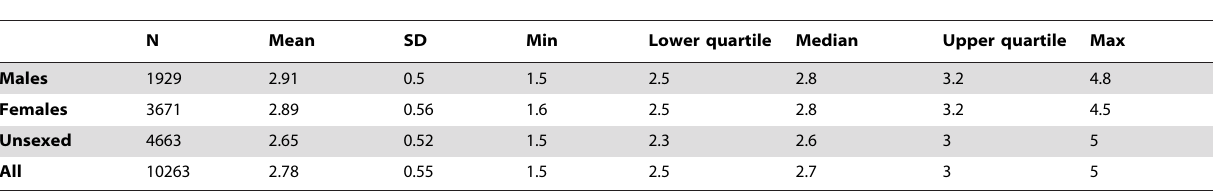
Table 3. Overall summary statistics of the total lengths (in meters) of white sharks in Gansbaai, January 2007 to December 2011.